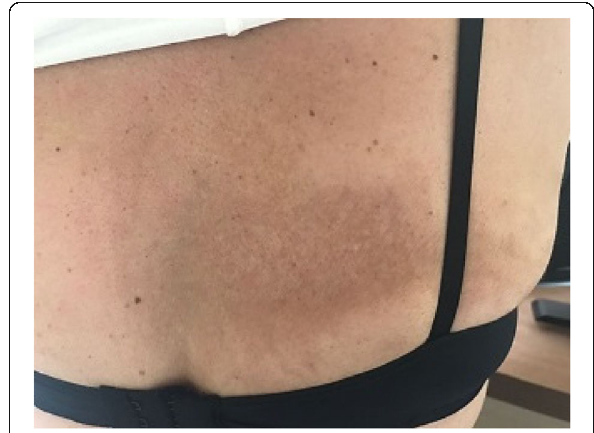
Fig. 1 (abstract P407). Cutaneous infiltration in orange peel appearance on the upper portion of back